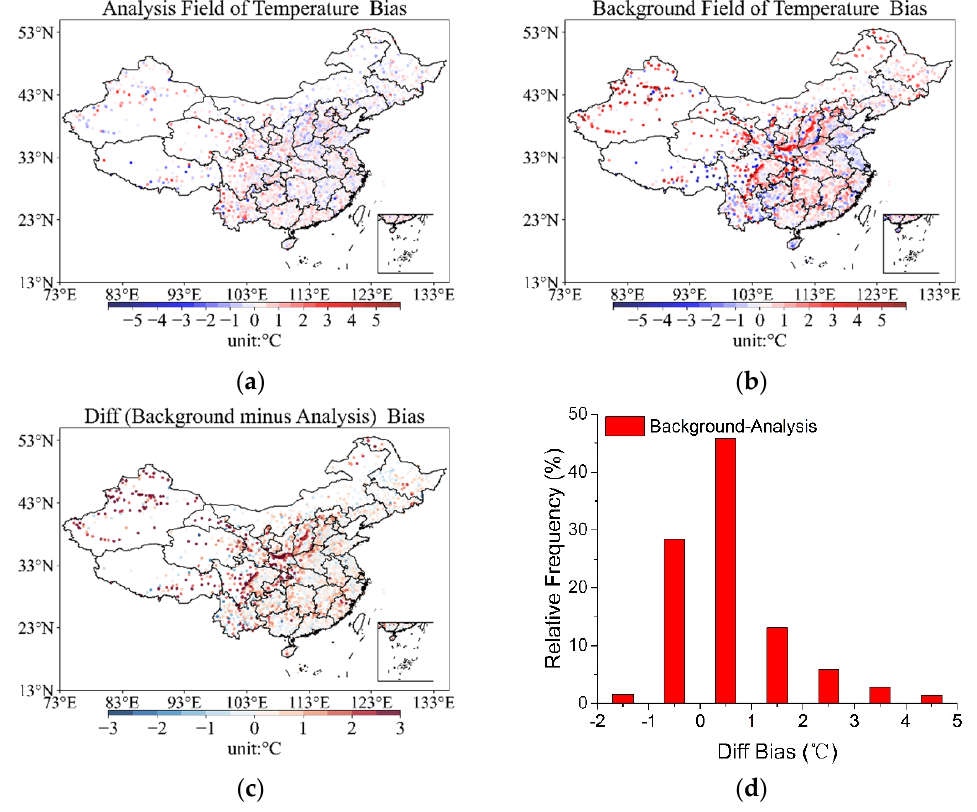
Figure 5. Statistical diagram of BIAS for temperature based on stations: ( a ) spatial distribution of BIAS for analysis field; ( b ) spatial distribution of BIAS for background field; ( c ) spatial distribution of the difference between background field and analysis field for BIAS; ( d ) frequency distribution of the difference between background field and analysis field for BIAS.